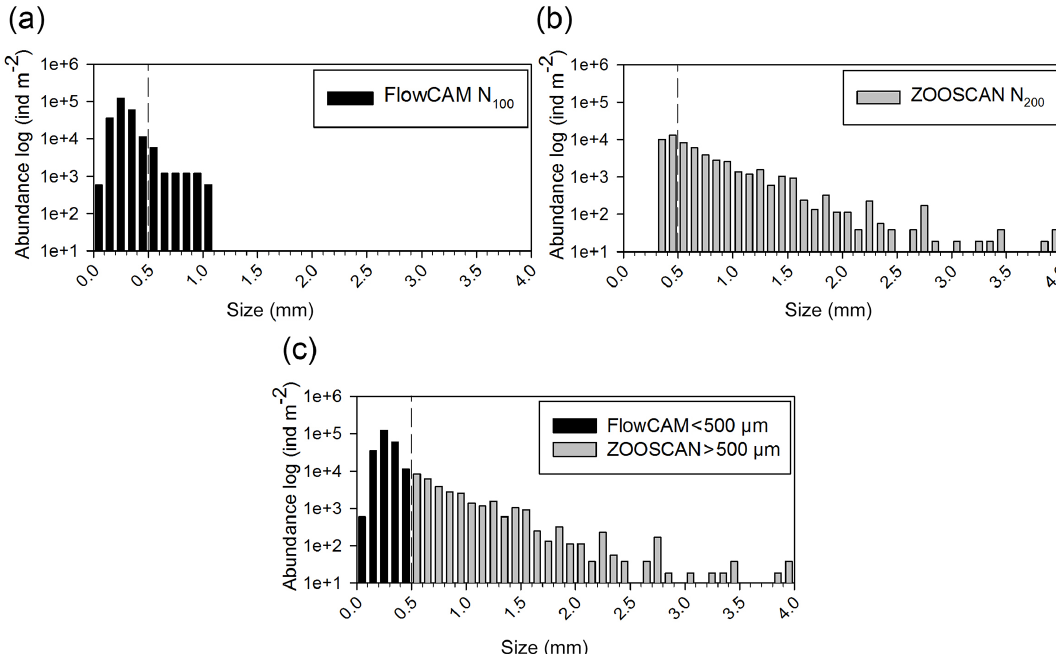
Figure 2. Size spectrum of ION1 (as an example) obtained by (a) FlowCAM ( N 100 ), (b) ZOOSCAN ( N 200 ), and (c) a combination of FlowCAM ( N 100 counting only zooplankton smaller than 500µm ESD) and ZOOSCAN ( N 200 counting only zooplankton bigger than 500µm